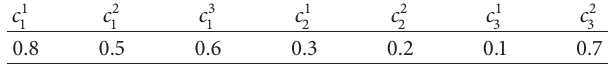
Table 1: Matched sequence procedure (𝑁) .